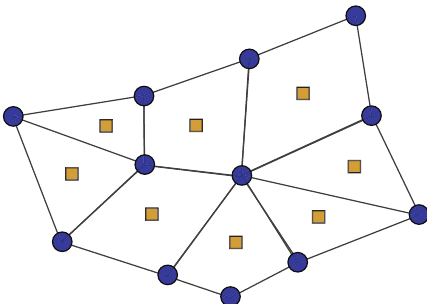
Figure 4: The finite volumes method computes the unknown flux in the cell centers (squares), whilst the finite elements method computes the fluxes at the nodes